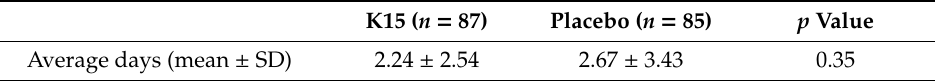
Table 2. The number of febrile days during the test period.